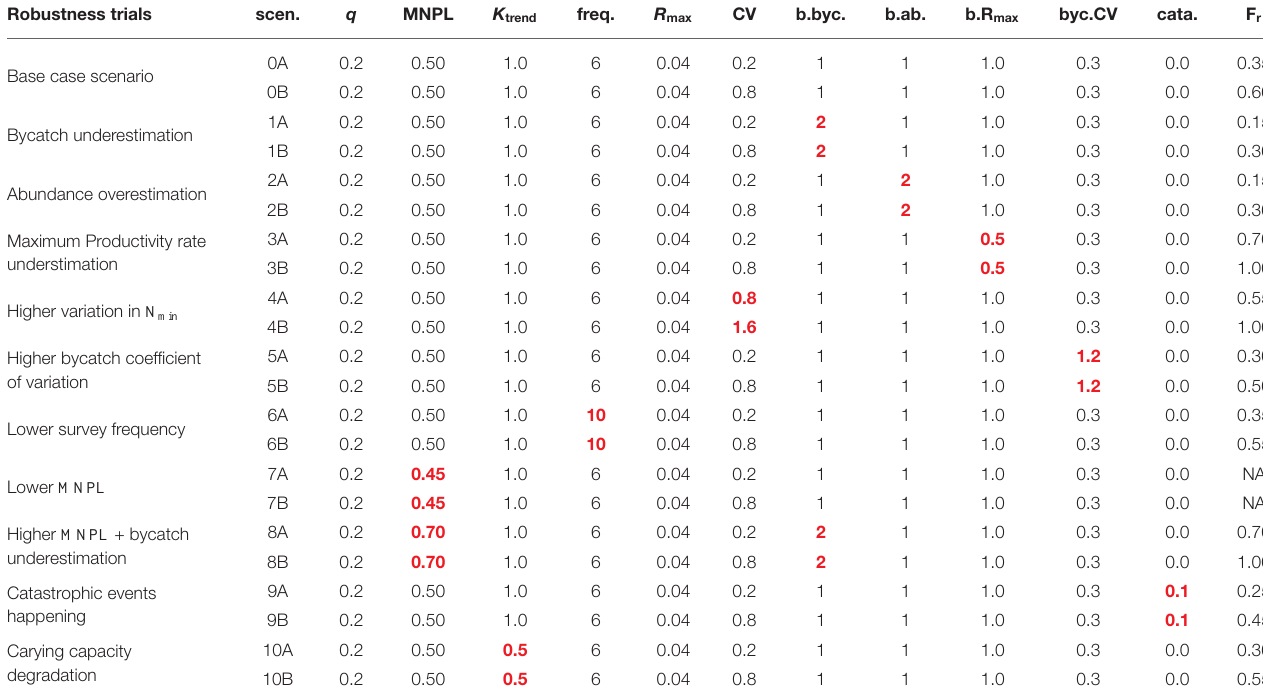
TABLE 3 | Summary of parameters combination for each robustness trial tested and Fr associated. Robustness trials